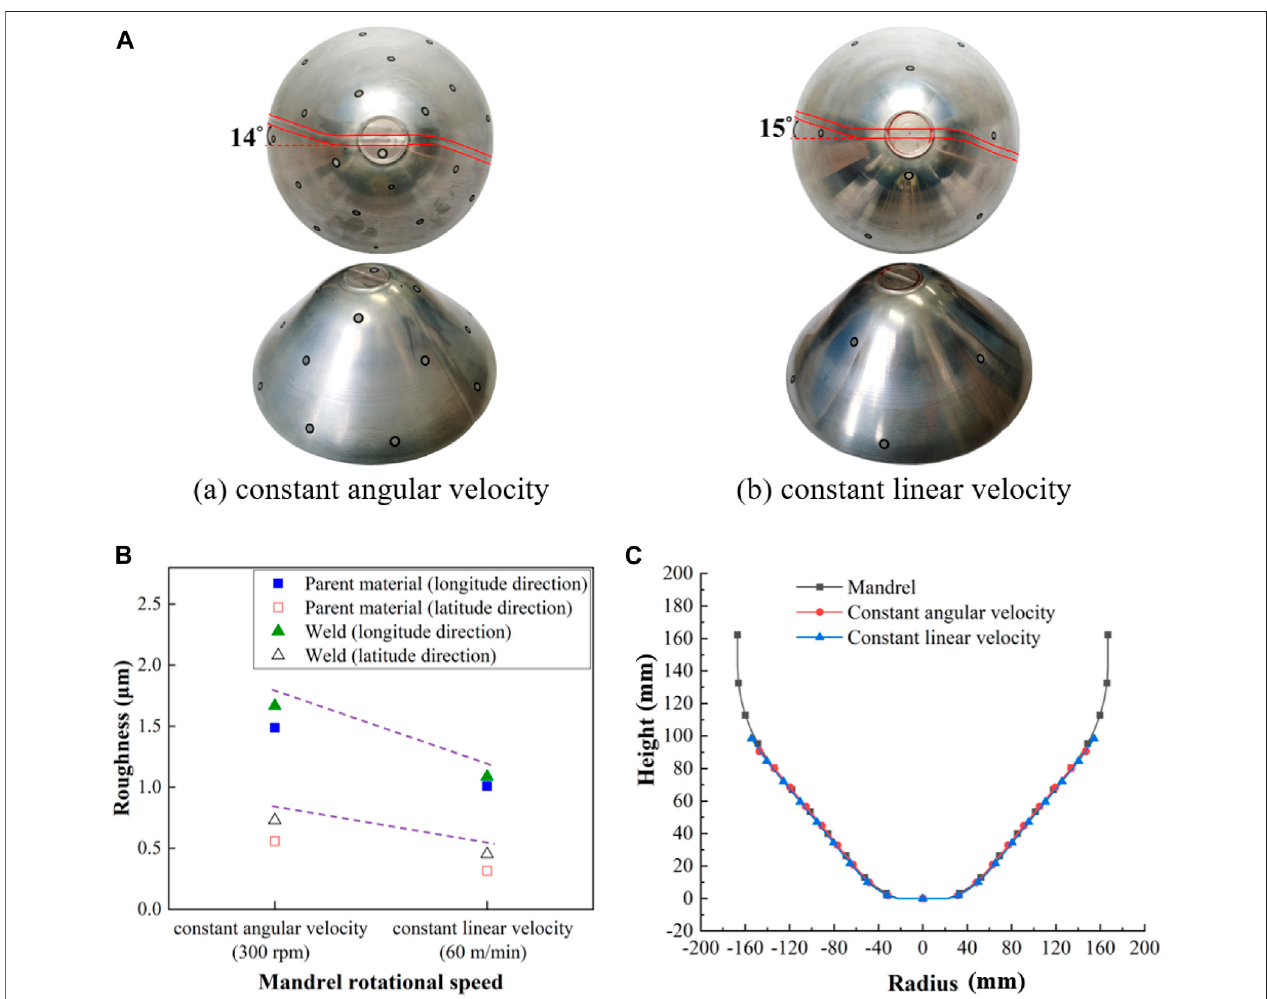
FIGURE 8 | Experimental results: (A) top and oblique views of spun parts under (a) constant angular velocity and (b) constant linear velocity; (B) surface roughnesses of spun parts and (C) forming pro fi le of spun parts.